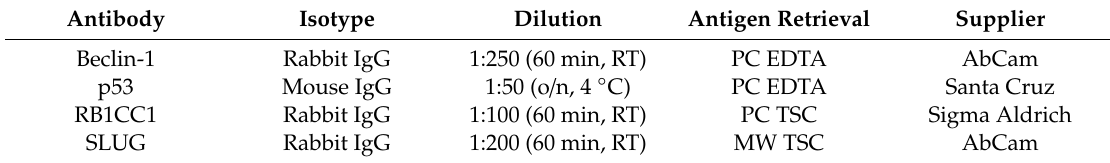
Table 5. Antibody source and